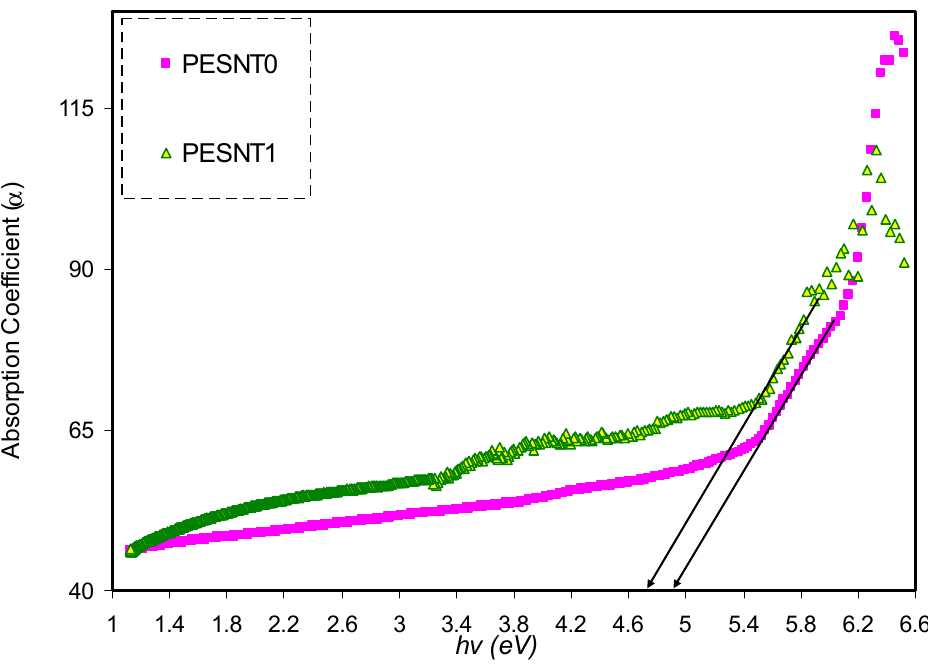
Figure 3. Optical absorption coe ffi cient ( α ) against photon energy of pure PEO (PESNT0) and PESNT1 composite samples.